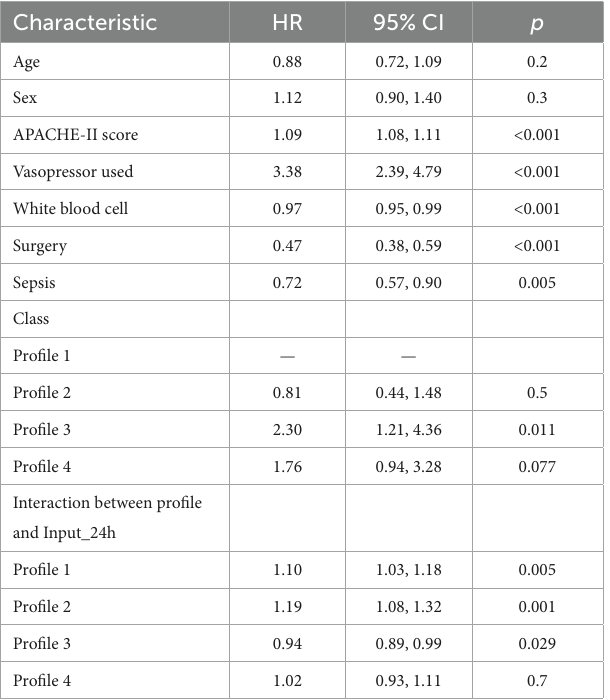
TABLE 4 Cox’s proportional hazard models for fluid input and hospital mortality in different